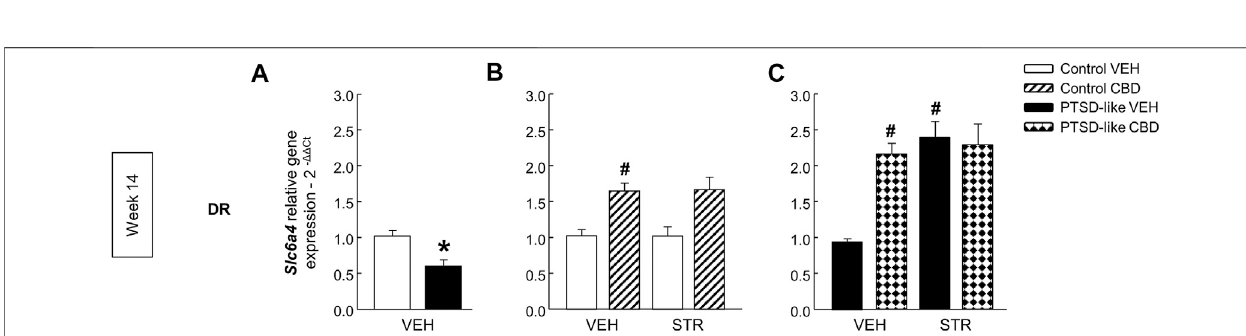
FIGURE 10 | Relative gene expression analyses of serotonin transporter ( Slc6a4 ) in the dorsal raphe nucleus (DR) by real time PCR at week 14. Comparative analysis between control and PTSD-like vehicle (VEH)-treated mice of the relative gene expression of Slc6a4 (A) in the DR. Effects of CBD (20 mg/kg) and/or STR (10 mg/kg) administration, or its corresponding VEH, on the relative gene expression of Slc6a4 in the DR of control (B) and PTSD-like (C) mice. Columns represent the means and vertical lines ± SEM of 2 - ΔΔ Ct . *, Values from PTSD-like mice that are signi fi cantly different from control mice (Student ’ s t -test, Slc6a4 : p < 0.001). #, Values from CBD- or STR-treated mice that are signi fi cantly different from VEH-treated mice (Two-way ANOVA, p < 0.05). Mice exposed to the PTSD-like model: N(VEH) (cid:2) 10, N(CBD) (cid:2) 9, N(STR) (cid:2) 9, N(CBD plus STR) (cid:2) 10; control mice: N(VEH) (cid:2) 10, N(CBD) (cid:2) 9, N(STR) (cid:2) 9, N(CBD plus STR) (cid:2) 10.